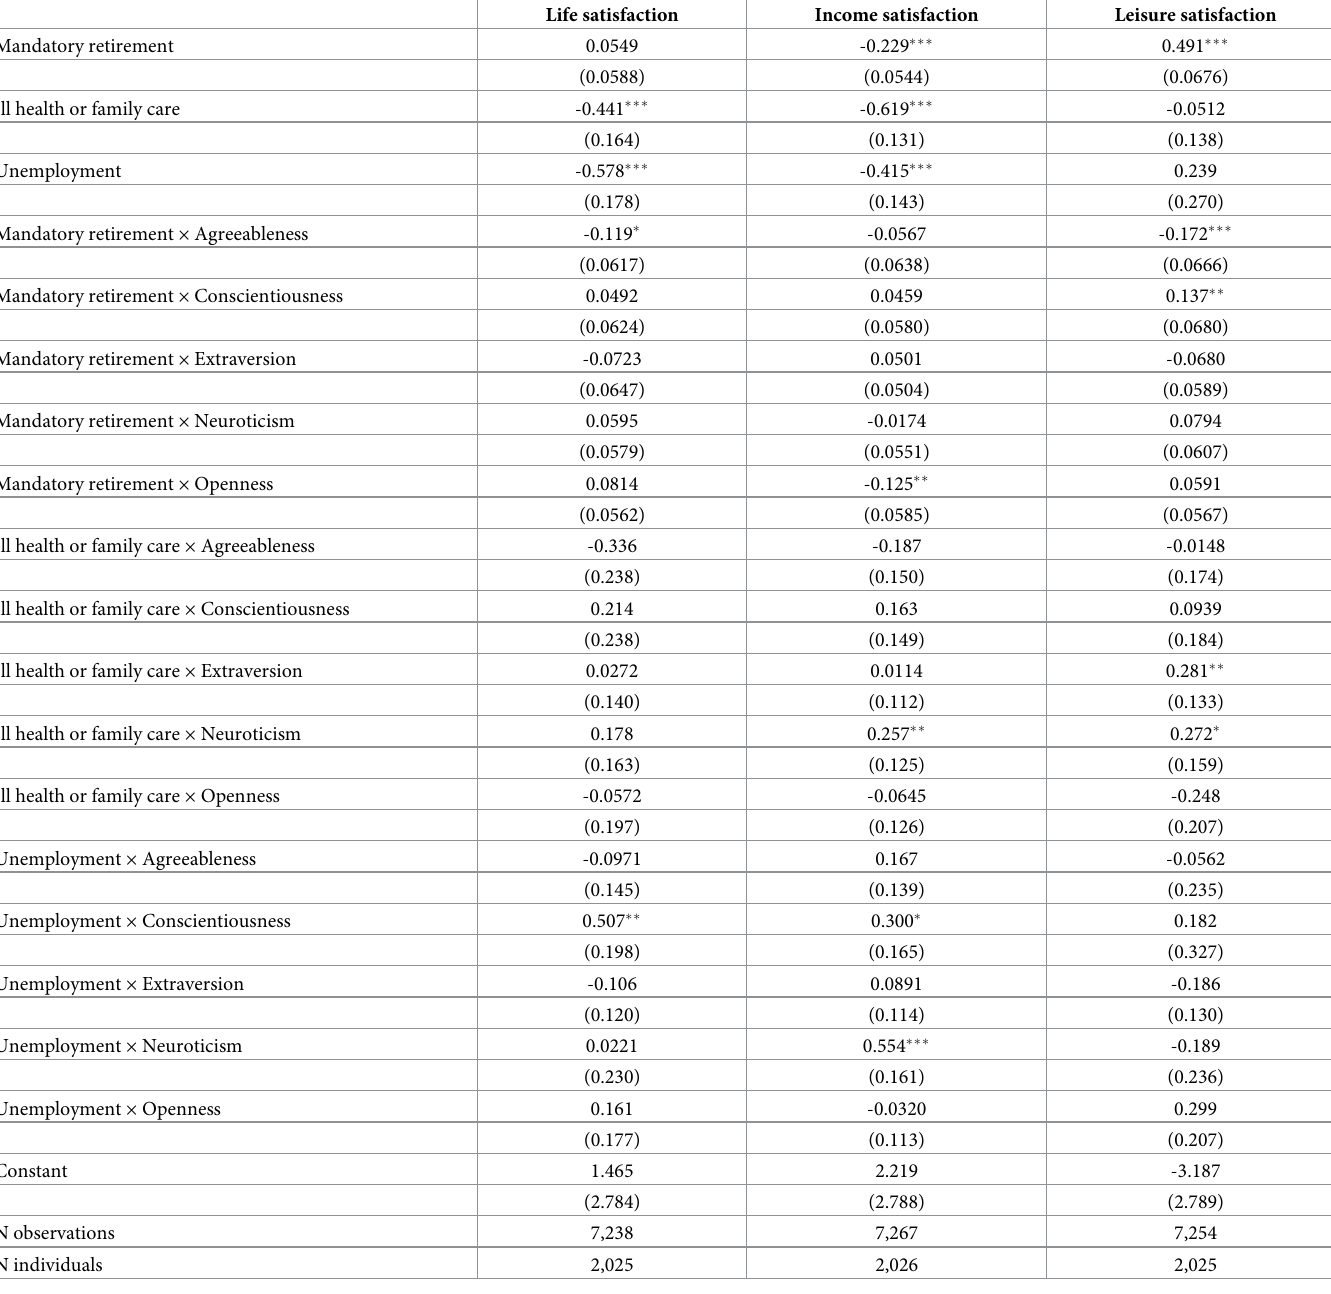
Table 6. Exit pathways, personality traits and well-being excluding those who retired